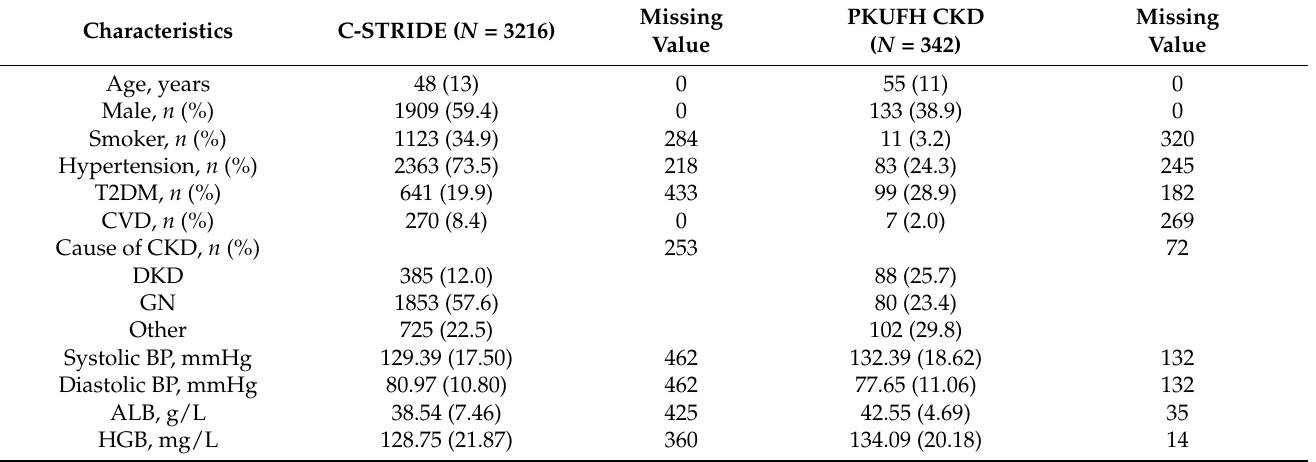
Table 1. Baseline characteristics of those participants with CKD in the development and validation